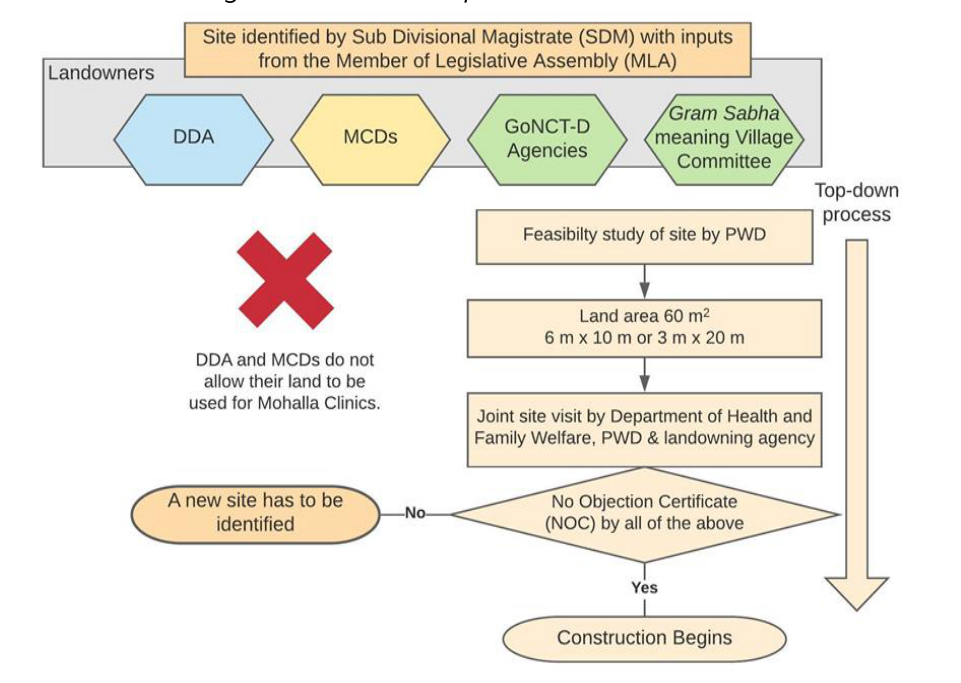
Figure 9: Site selection process for Mohalla